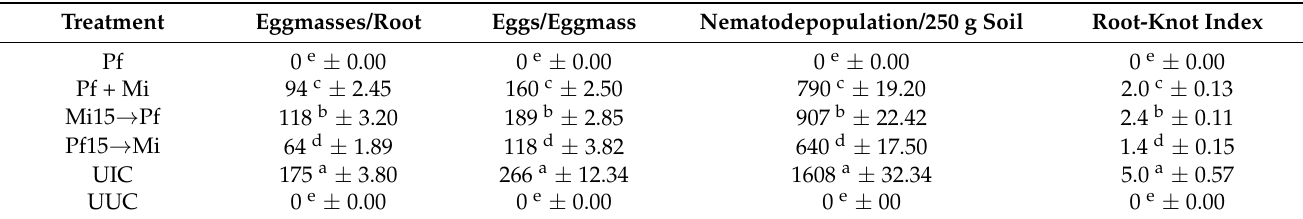
Table 3. Impact of individual, concomitant and sequential inoculation of Meloidogyne incognita and Pseudomonas fluorescens on nematode multiplication in tomato cv. K-21 in